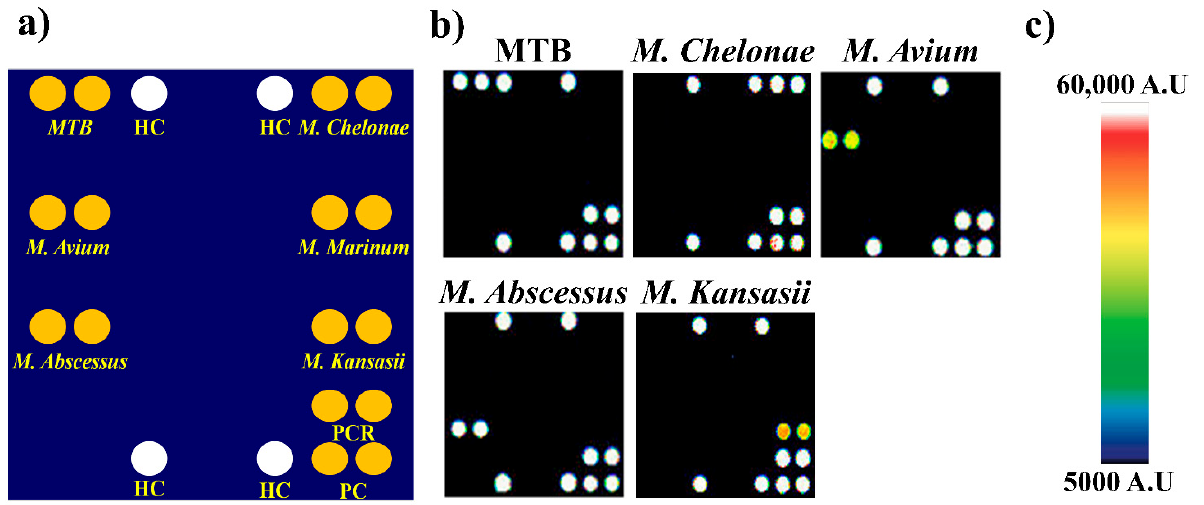
Figure 2. Detection and discrimination of the MTB and NTM strains: ( a ) scheme depicting positions of the immobilized probes; ( b ) hybridization of the Cy5 ‐ ssDNA in the PCR products of MTB and respective NTM strains with the immobilized probes; ( c ) fluorescence scale.